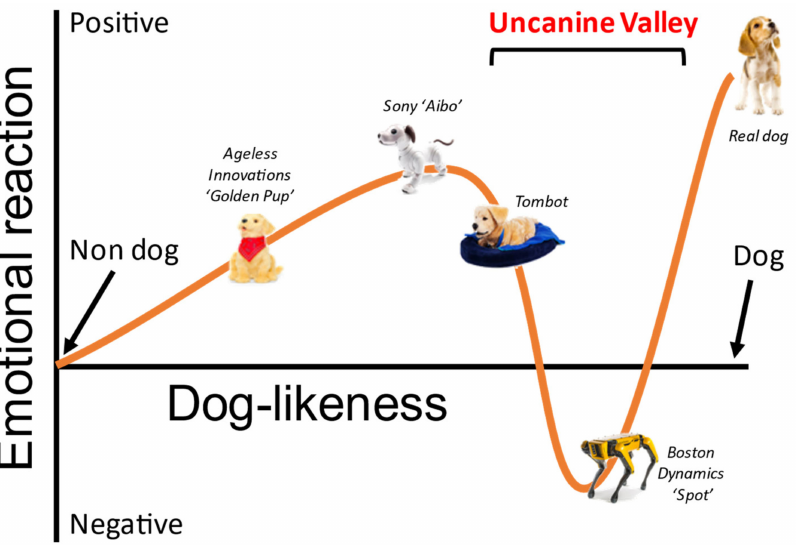
Figure 1. Representation of the “uncanine” valley, a hypothesized adaption of the uncanny val- ley. “Dog-likeness” is defined as the degree to which an object is designed to mimic the form, characteristics, and behavior of a real